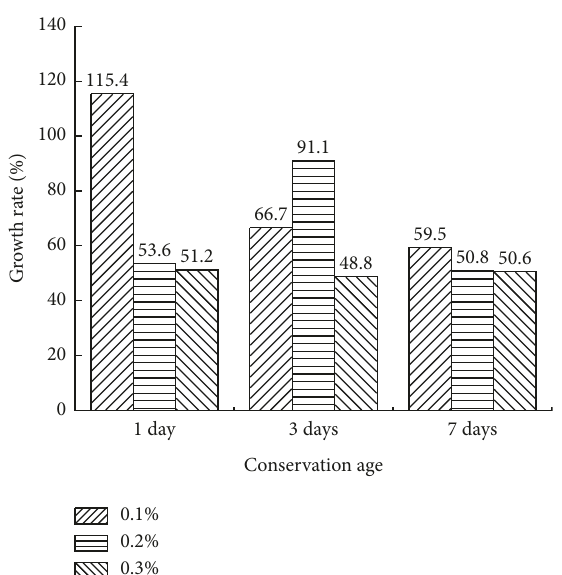
Figure 11: Change rate of the vibration number with fiber length modulus for cured remolded soils.